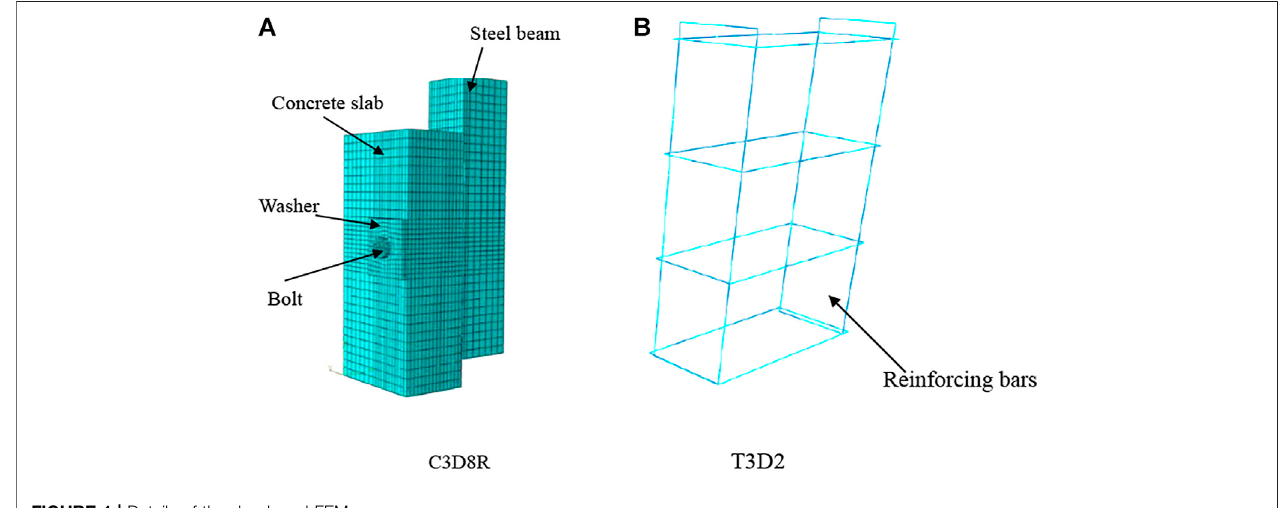
FIGURE 1 | Details of the developed FEMs.